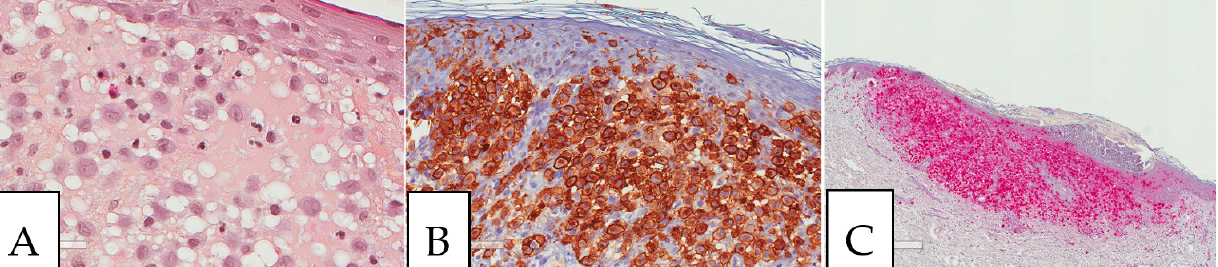
Figure 6. Rosai Dorfman disease. ( A ) . Cutaneous Rosai Dorfman disease showing histiocytes with an enlarged eosinophilic cytoplasm with engulfed inflammatory cells (emperipolesis). ( B ) . S100- positive lesional cells. ( C ) . CD1a-negative lesional cells. This biopsy was performed on a 64-year- old-female patient presenting with pigmented lesions of the back suspicious of regressive mela- noma.